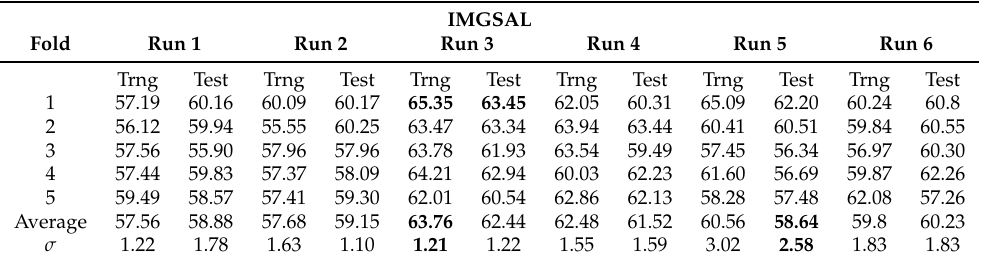
Table 13. Performance of the best individuals of the GBVSBP model for all IMGSAL database runs. Each pair of training and testing corresponds to one experiment of the k-fold. Therefore, we obtain 30 executions of our system and report the standard deviation for each run set.